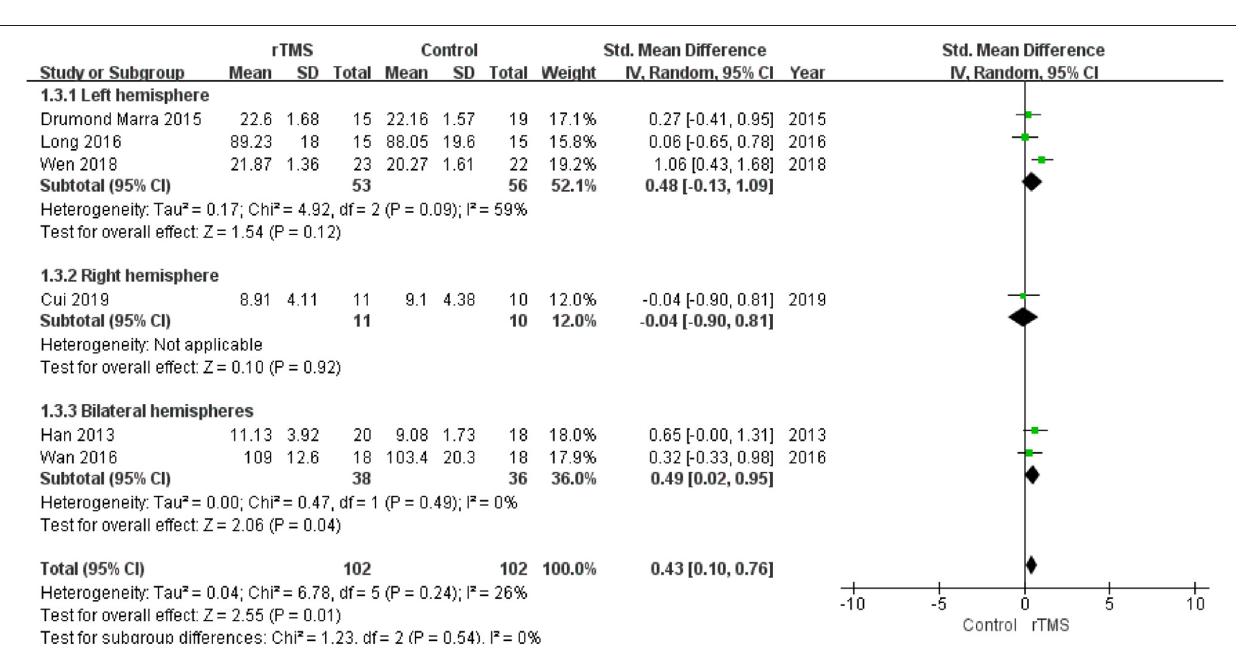
FIGURE 8 | Meta-analysis forest plot of subgroup analysis showing memory of repetitive transcranial magnetic stimulation group vs. control group in the treatment of mild cognitive impairment: left hemisphere vs. right hemisphere vs. bilateral hemispheres.